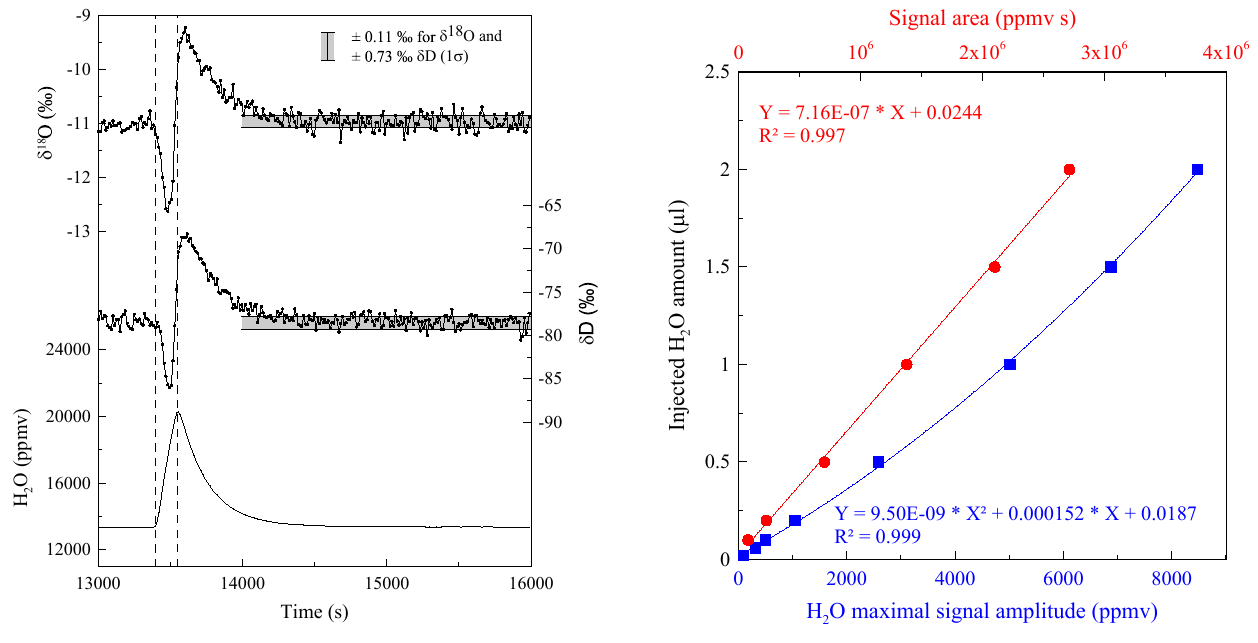
Figure 8. These spectrograms show the δ 18 O, δD and H 2 O re- sponses of the Picarro for a speleothem sample measurement (Fig. 7, peak 4). Both isotope ratios behave similarly. Due to diffu- sional fractionation of the light and heavy water isotopologues dur- ing the sample transfer by nitrogen, depleted values are observed for the very first part of the sample. Maximal isotope values are reached after the maximum of the water amount. The signals reach background stability again after about 20min.